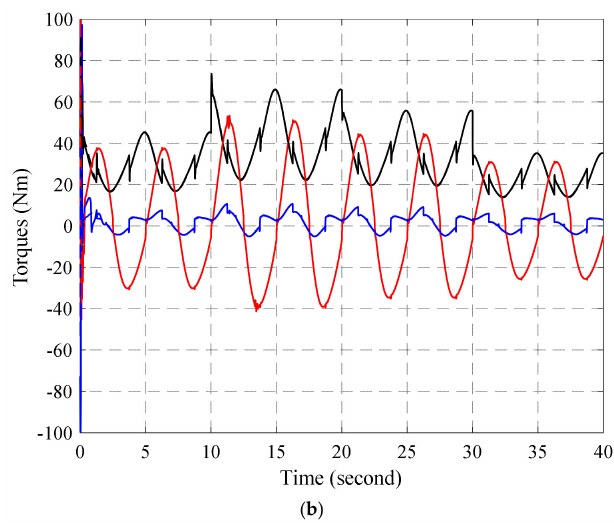
Figure 6. Torque responses with ( a ) BSMC, and ( b ) ABSMC.